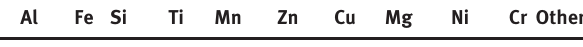
Table 3 Chemical composition of Al.